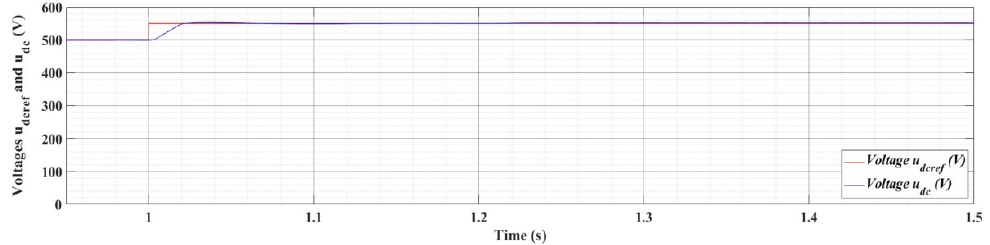
Figure 49. The time evolution of voltage u dc for a step variation of the u dcref reference voltage from 500 V to 550 V using SMC- and SYN-type controllers and the RL-TD3 agent for the correction of the i dref , u dref and u qref commands (signal evolution of the type 2 PV array).